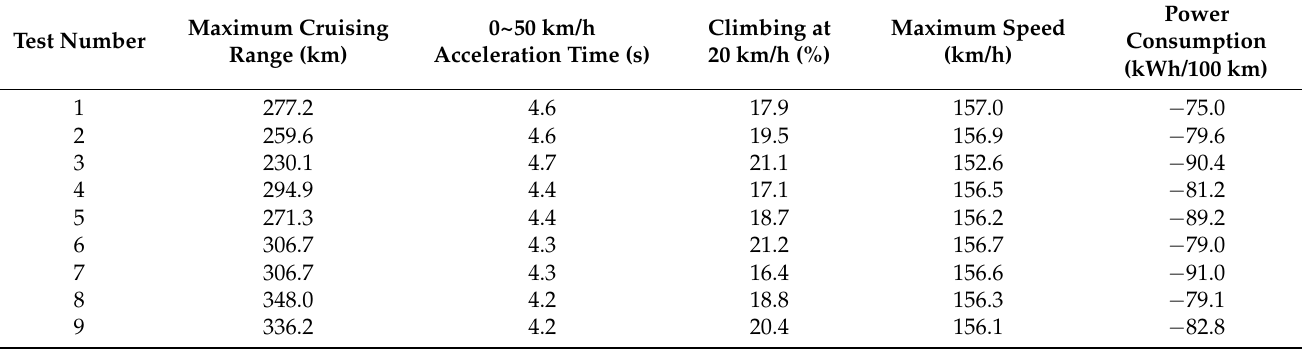
Table 11. Orthogonal experimental results.